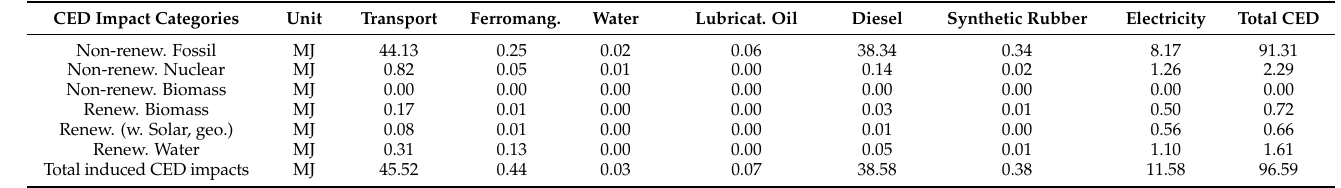
Table 3. Characterized induced CED impacts associated with the collection and recycling of 1 tonne of C&DW. CED Impact Categories Unit Transport Non-renew. Fossil Non-renew. Biomass